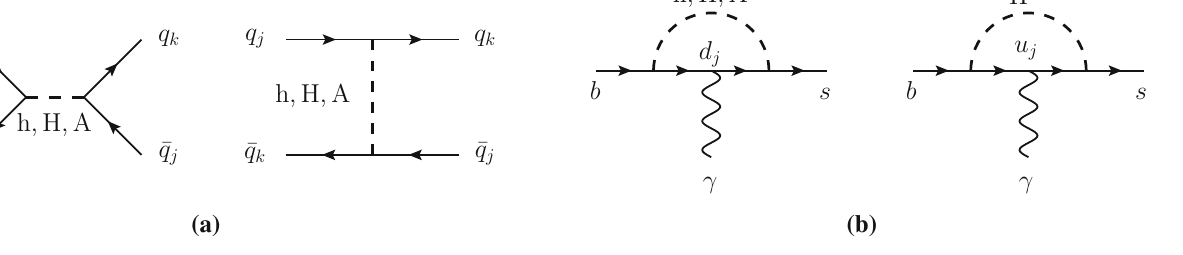
Fig. 5 Diagrams contributing to: a meson mixing, b b → s γ sector verifying boundedness, perturbative unitarity,